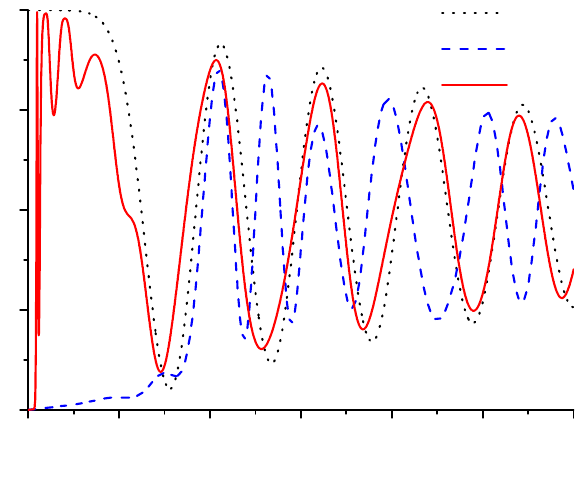
Figure 3. Dynamics of population difference at the entrance of non-adiabatic front in the medium with different disorder strengths r